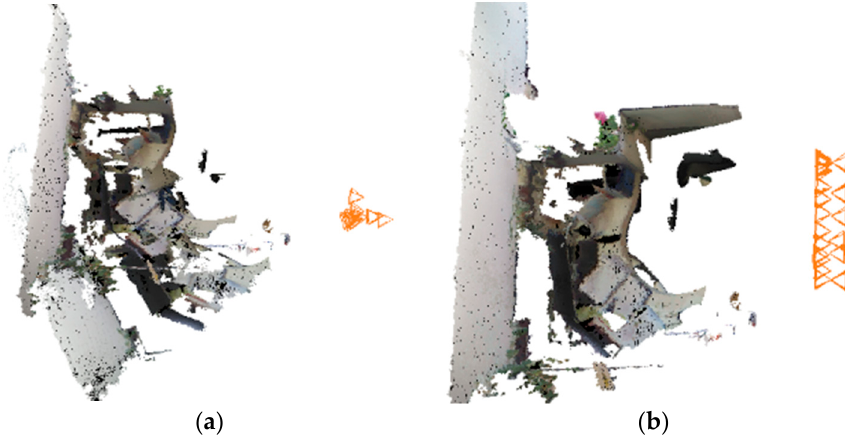
Figure 9. Comparison of single-camera SLAM result and two-camera SLAM result when one of the cameras is occluded. ( a ) is the single-camera SLAM result; ( b ) is the two-camera SLAM result.